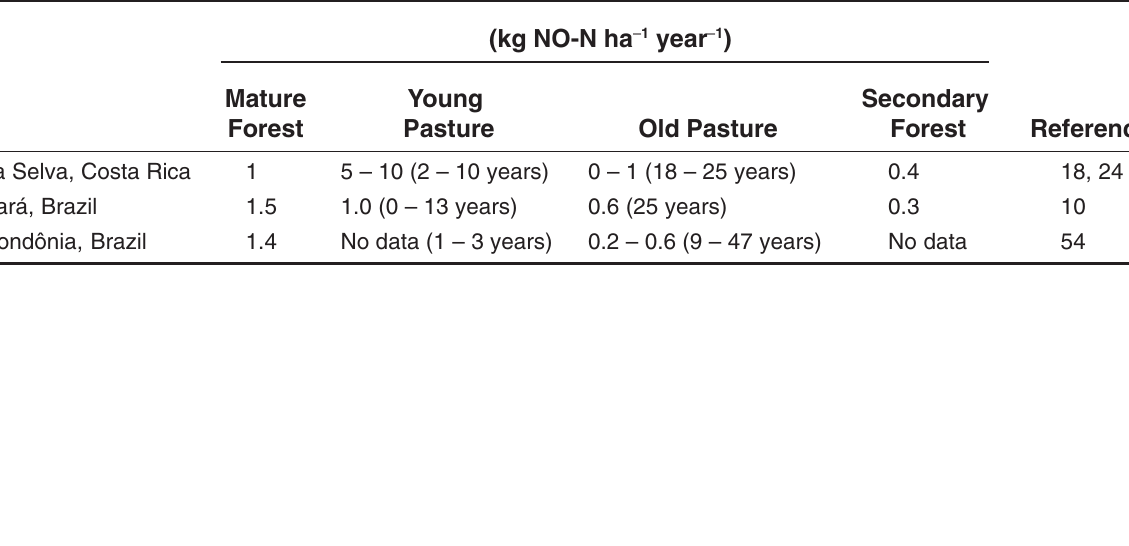
Effects of Tropical Forest-Pasture Conversion on Soil Emissions of Nitric